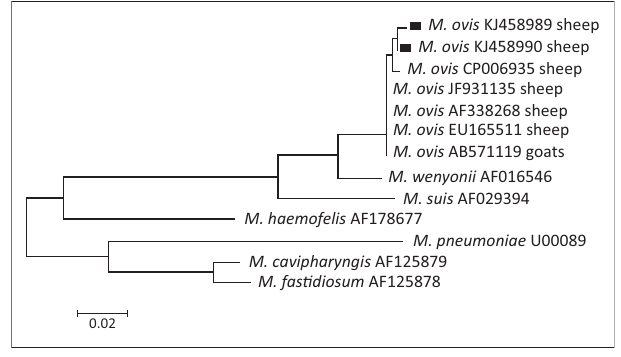
FIGURE 2: Partial sequence 16S rRNA gene phylogenetic tree of Mycoplasma ovis identified in this survey and the main Mycoplasma species. The tree was constructed using the neighbour-joining method. The percentage of replicate trees in which the associated taxa clustered together in the bootstrap test (1100 replicates) was shown next to the branches (Felsenstein 1985). The evolutionary distances were computed using the Tamura-Nei method (Tamura & Nei 1993) and are in the units of the number of base substitutions per site. Evolutionary analyses were conducted in MEGA5.1 (Tamura et al. 2011). Species described in this study are indicated with a black